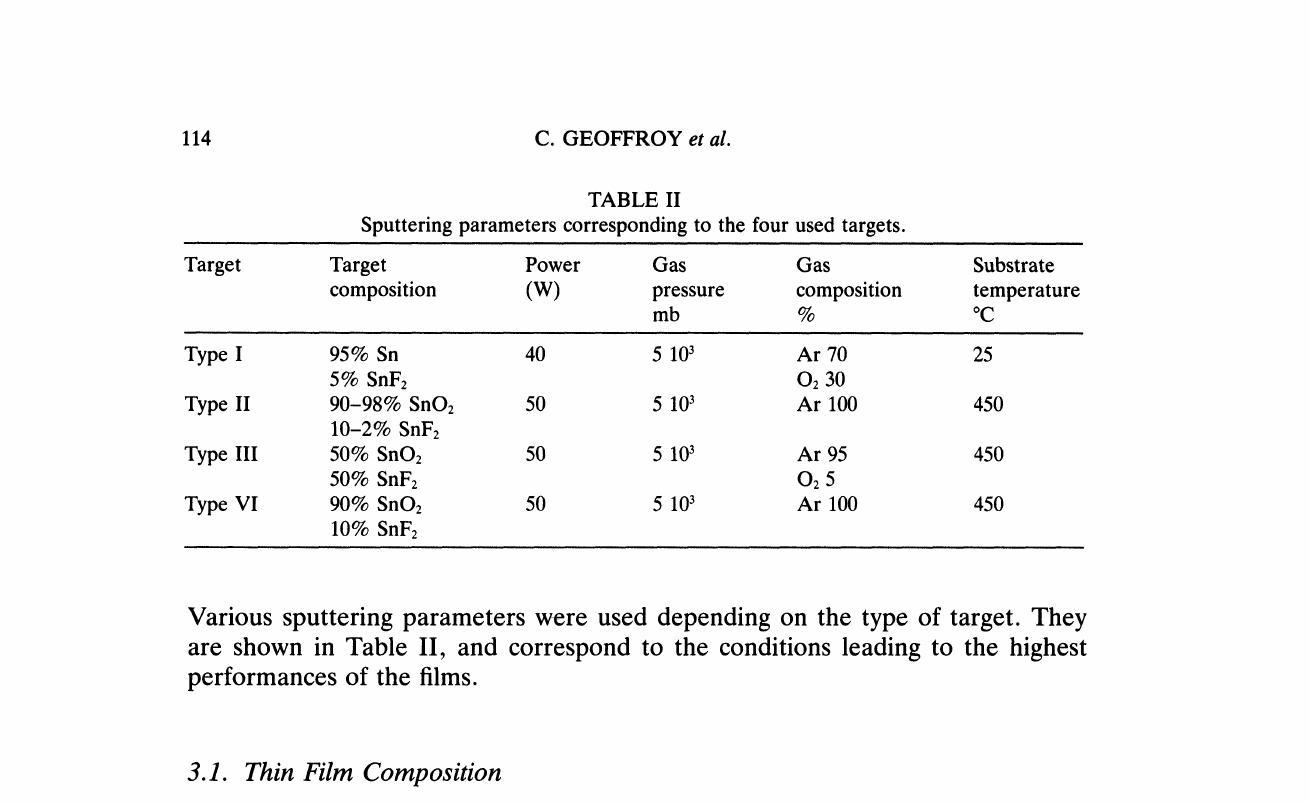
Sputtering parameters corresponding to the four used